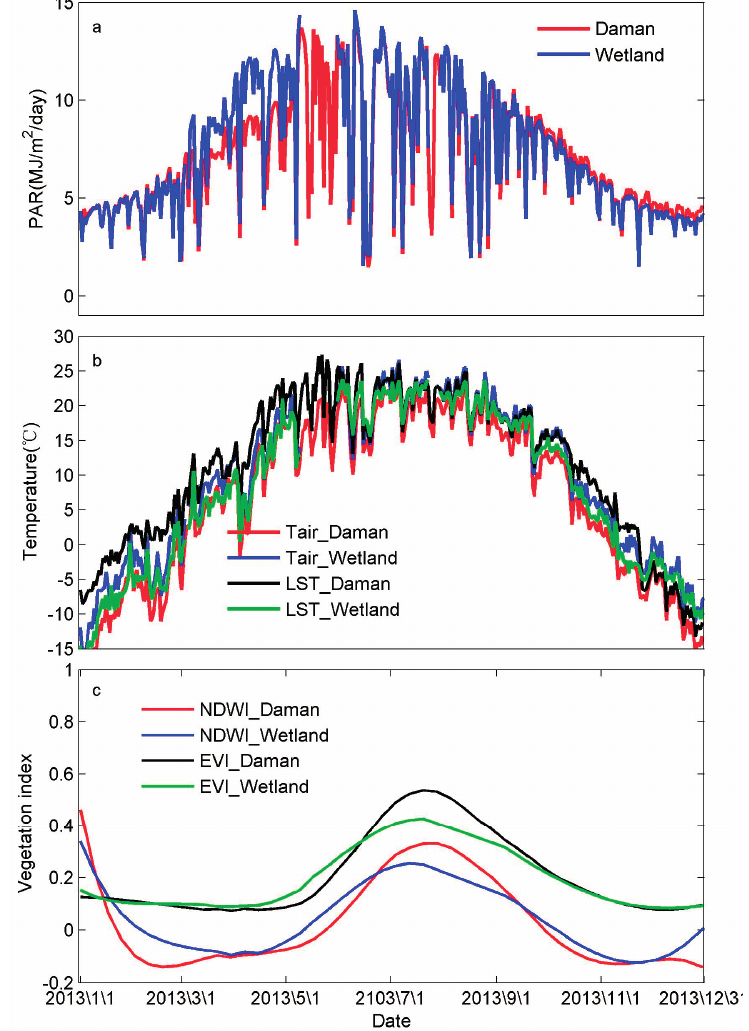
Figure 2. Seasonal dynamics of the PAR ( a ), air temperature (Tair), land surface temperature (LST) ( b ) and vegetation indices (NDWI and EVI) ( c ) at the Daman superstation and Zhangye wetland